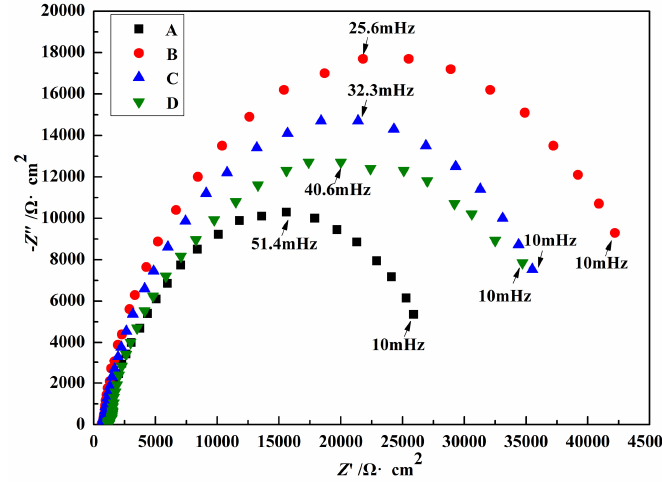
Figure 9. Nyquist plots of the samples immersed in the four solutions.